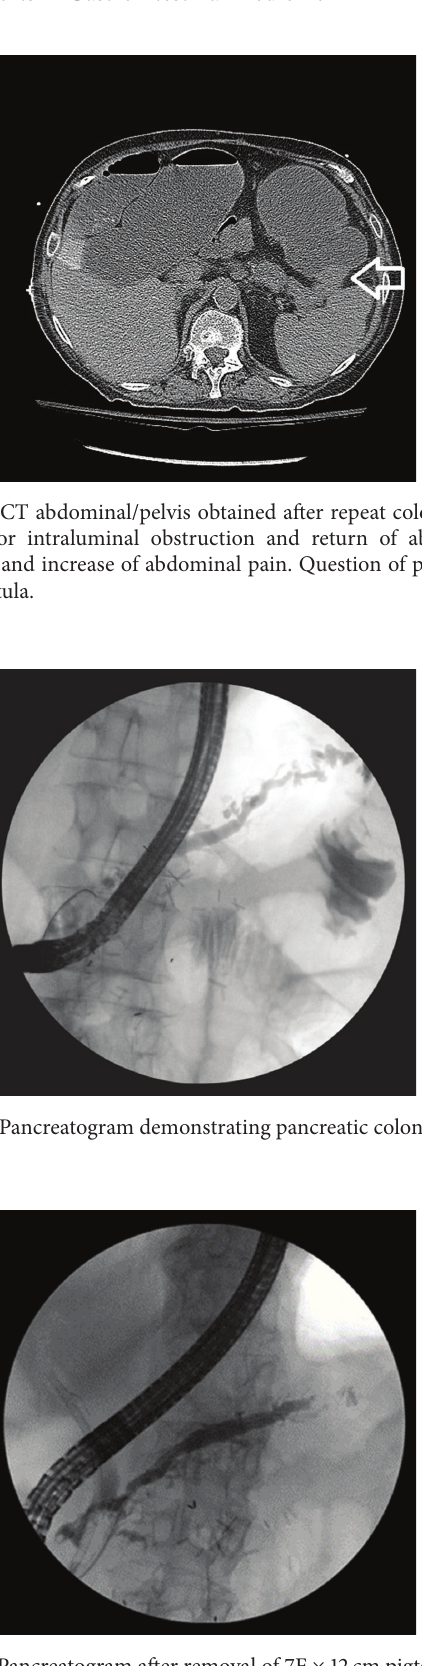
Figure 7: Pancreatogram after removal of 7F × 12cm pigtail plastic stent in place for 3 months with resolution of the pancreatic colonic